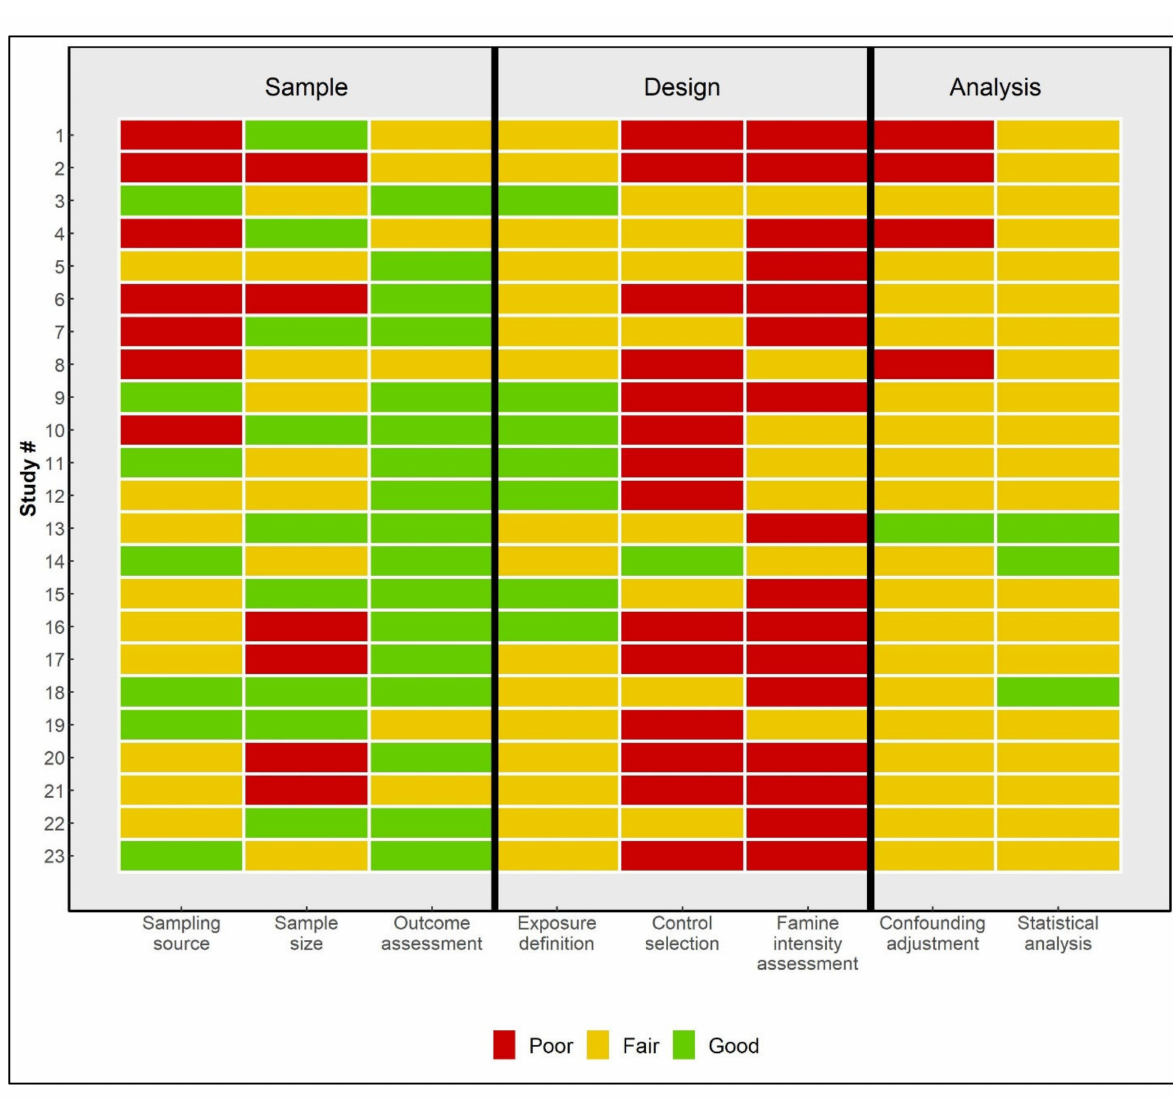
Figure 5. Quality assessments of the included studies. Study # is the same as in Table